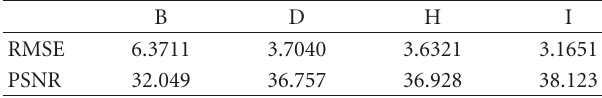
Table 2: RMSE and PSNR (dB) values of denoised images B, D, H and